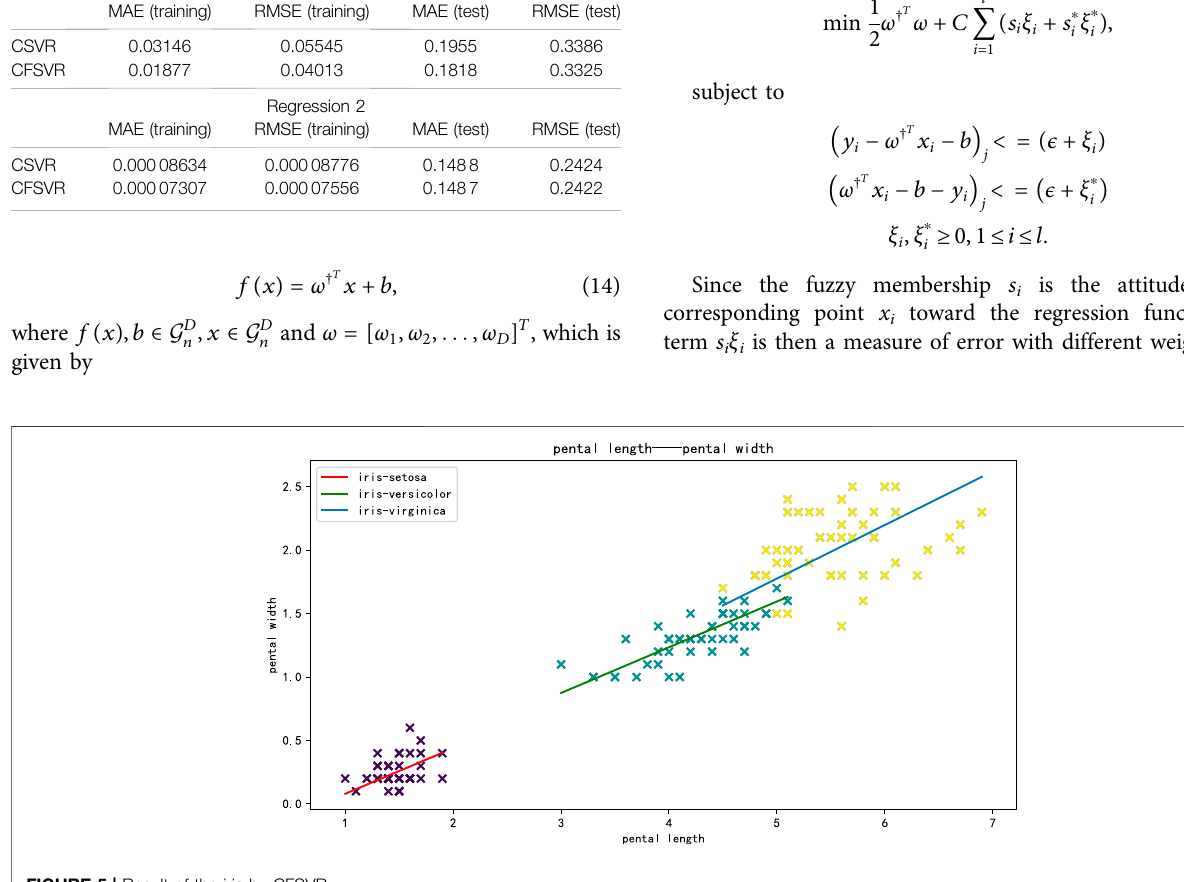
FIGURE 5 | Result of the iris by CFSVR.